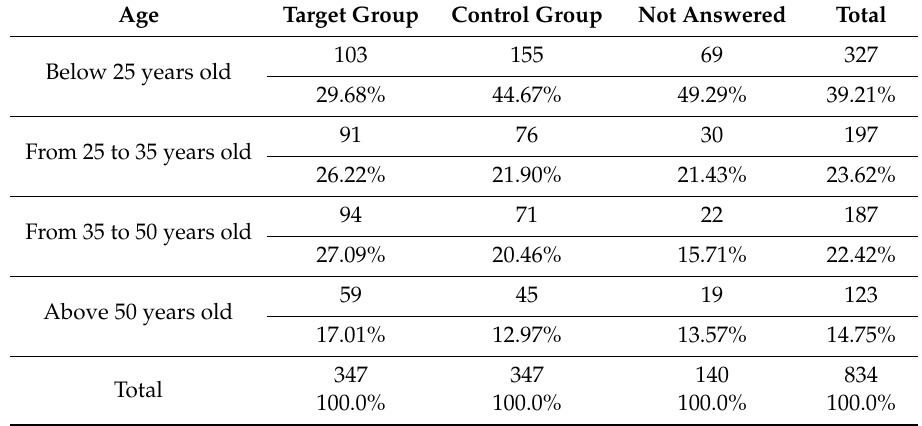
Table 2. Cross tabulation of respondents’ age and belonging to target and control groups (N, %). Age Target